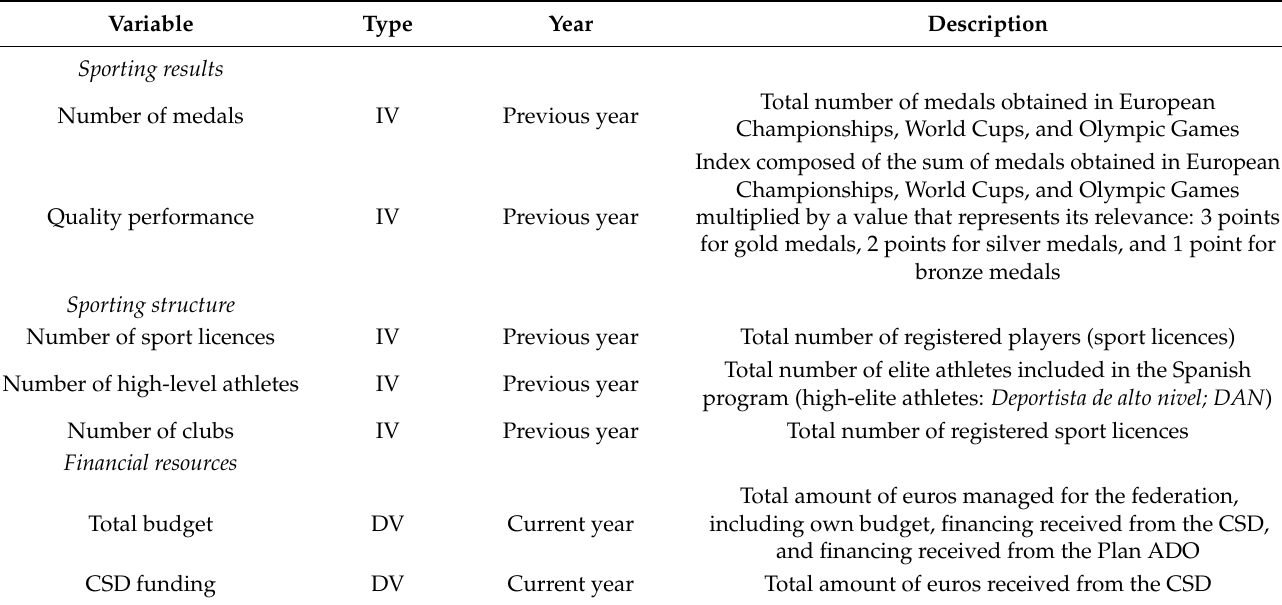
Table 1. Variables of the study.